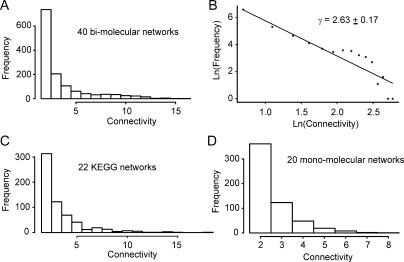
Connectivity Distribution of Simulated and Natural Networks(A) Connectivity distribution of 40 different simulated networks. As in the sample simulation, most metabolites are only involved in two or three reactions. On the other hand, the distribution shows that there are a number of hubs that are involved in up to 16 reactions.(B) The double-logarithmic plot of the distribution reveals a considerable deviation from a power-law distribution.(C) Connectivity distribution in natural metabolic networks of similar size. The networks are generated from the KEGG database for E. coli (see Materials and Methods). The connectivity distribution of the simulated networks is consistent with that of the natural networks (chi square test: p ≍ 0.085; see Materials and Methods).(D) Simulations for monomolecular reaction networks. The initial network is equivalent to the group transfer networks (see Figure 1C). In contrast to the group transfer network, we assume that groups are not transferred, but are added or removed by the enzymes. Therefore a reaction can transform a donor into its corresponding acceptor without being coupled to another half-reaction. The connectivity distribution of the emerging networks clearly differs from the connectivity distribution in the bimolecular group transfer networks. In particular, hubs are comparatively rare. This indicates that group transfer plays a key role in the emergence of hubs.